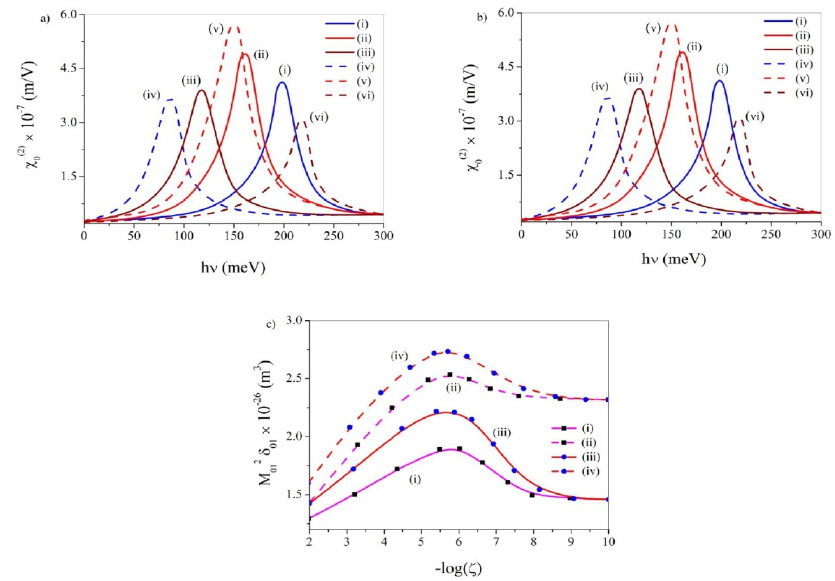
Figure 6. NOR vs. h υ diagrams with ( a ) OPA and ( b ) EPA. In these diagrams (i) ADWN and ζ = 10 − 10 , (ii) ADWN and ζ = 10 − 6 , (iii) ADWN and ζ = 10 − 2 , (iv) MLWN and ζ = 10 − 10 , (v) MLWN and ζ = 10 − 6 , (vi) MLWN and ζ = 10 − 2 . ( c ) Depiction of GF for NOR vs. –log( ζ ): (i) with ADWN and OPA, (ii) with ADWN and EPA, (iii) with MLWN and OPA and (iv) with MLWN and EPA. Under EPA the physical traits of the NOR profiles show qualitative analogy with the similar profiles under OPA. Hence, these diagrams are not elaborated. Thus, the physical attributes of the NOR diagrams are not influenced by the symmetry of the anharmonicity as ζ varies.